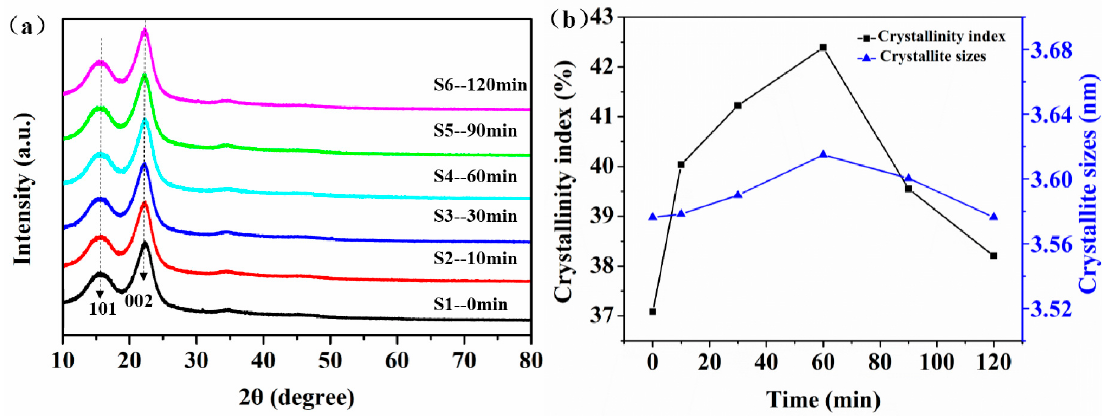
Figure 4. ( a ) X-ray Diffractometry (XRD) analysis and ( b ) crystallinity index (CI) and crystallite size (CS) of unmodified and modified jute fabrics.